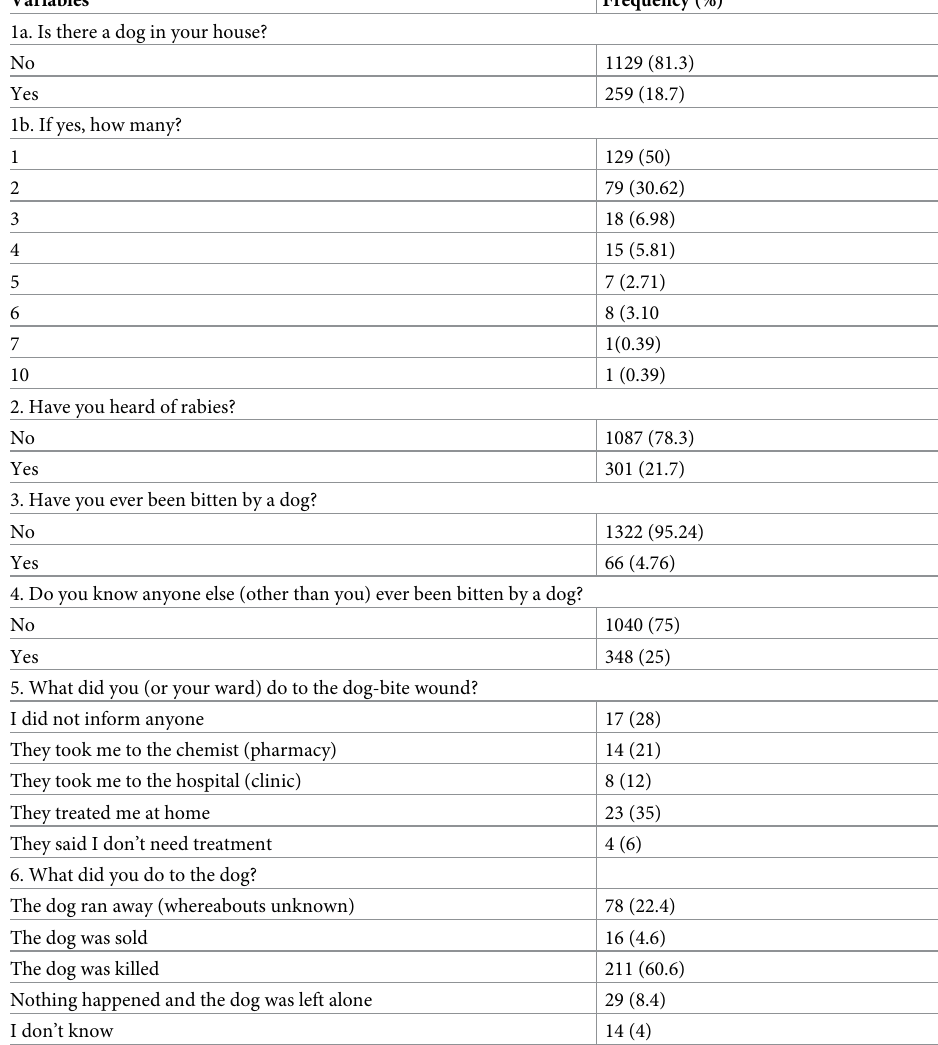
Table 3. Perception of canine rabies among pupils under 15 years in Kwara state Nigeria (n = 1388). Variables Frequency